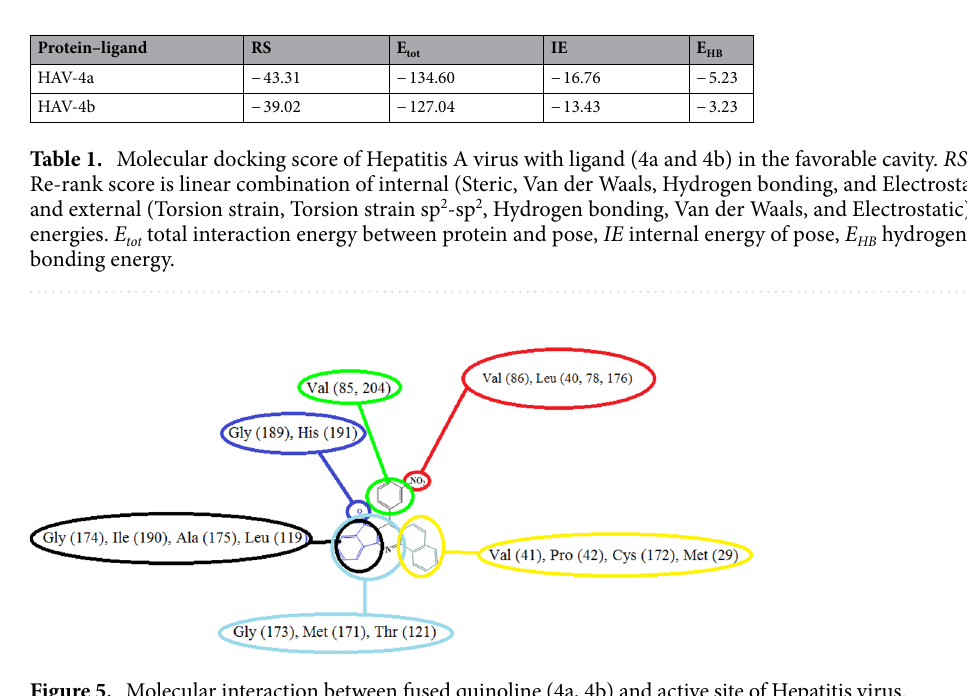
turquoise, yellow, red and blue colors in the energy map of Hepatitis virus might contribute in favorable steric interaction, hydrogen acceptor, hydrogen donor, electrostatic potential with the ligand 51 . While steric, hydrogen